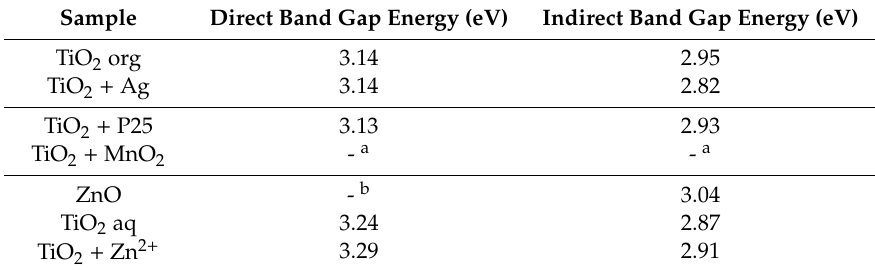
Table 2. Band gap energies calculated by the Kubelka–Munk method from di ff use reflectance measurements on powders for the di ff erent allowed electronic transitions.